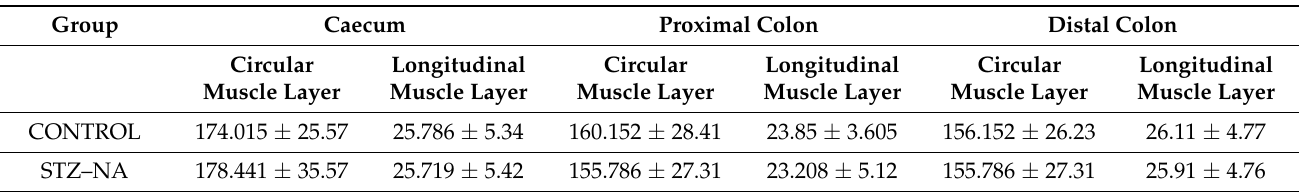
Figure 1. HE ( a , b ), desmin ( c , d ) and PDGFR α ( e , f ) immunohistochemistry. In the muscle layer of both groups ( a , b ), ganglia of the myenteric plexus (black arrow) were observed at the border of the circular and longitudinal sublayers. Inside the muscle layer, there were no signs of lymphocytic infiltration, apoptosis or necrosis ( a , b ). Desmin-immunoreactivity was present in the wide circular and the thin longitudinal muscle layer of control ( c ) and STZ–NA ( d ) rat colon. PDGFR α immunoreactive cells ( e , f ) in the submucosa (white arrow) and within the muscular layer (black arrow), lm (longitudinal muscle layer) cm (circular muscle layer). ( a ) proximal colon of control group; × 200. ( b ) proximal colon of STZ–NA group; × 200. ( c ) proximal colon of control group; × 200 ( d ) proximal colon of STZ–NA group; × 200 ( e ) distal colon of control group; × 200. ( f ) distal colon of the group with diabetes; × 200. Table 3. Thickness of circular and longitudinal muscle layer in control and diabetic (STZ–NA)